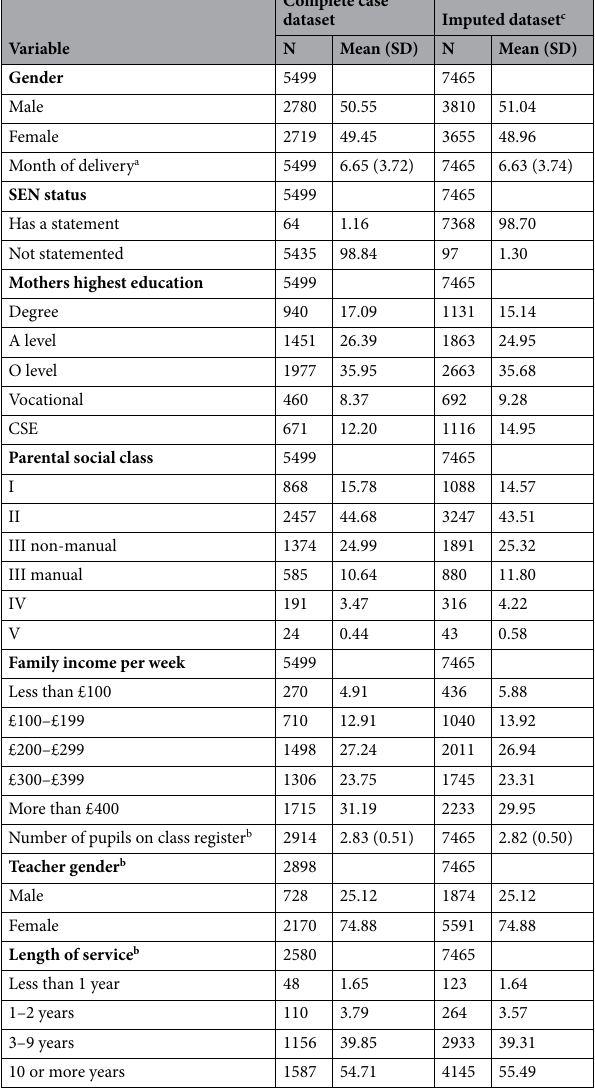
Table 4. Complete case and imputed summary statistics. Imputed summary statistics calculated from 100 imputed datasets. a Where September = 1, October = 2 etc. to reflect the month of entry in UK schooling. b Information available for KS2 only. c Summary statistics calculated from 100 imputed